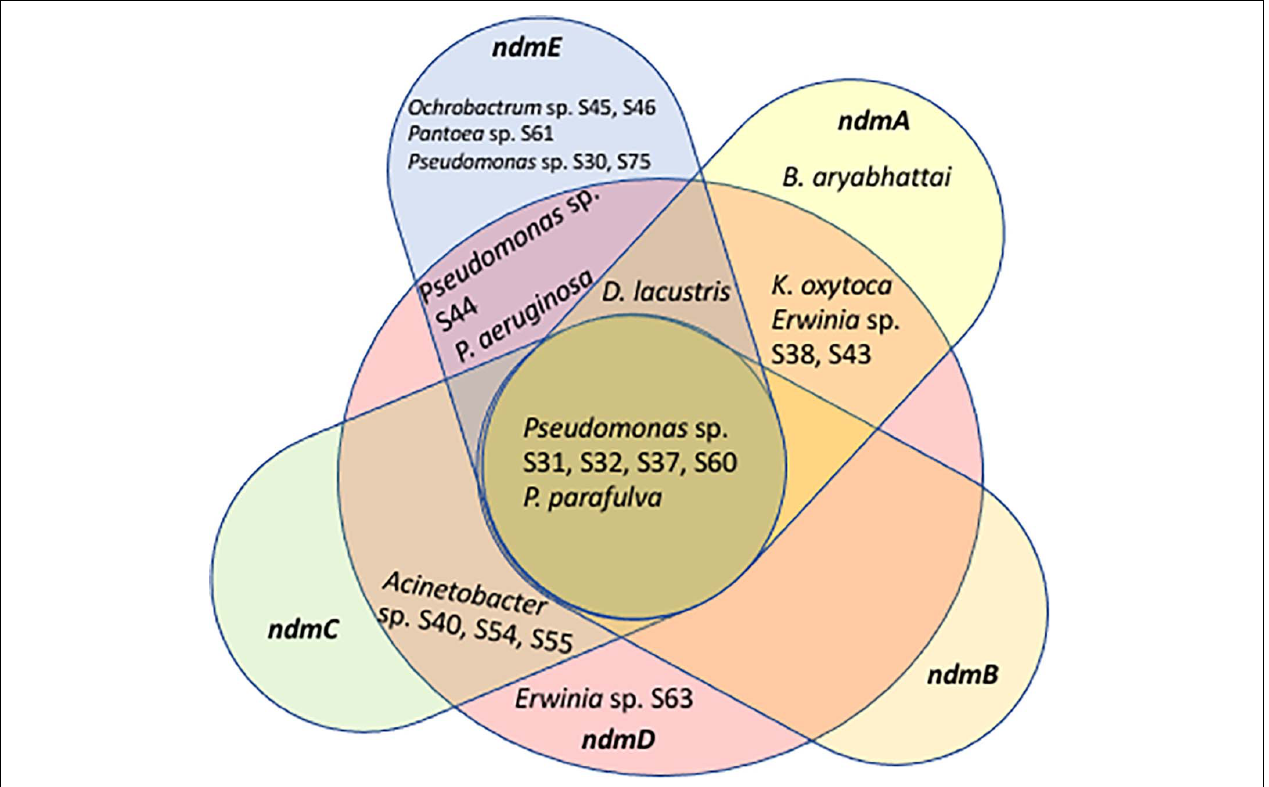
FIGURE 3 | Venn diagram showing genes involved in the caffeine N-demethylation pathway shared among Acinetobacter sp. S40, S54, S55, Bacillus aryabhattai , Delftia lacustris , Erwinia sp. S38, S43, S63, Klebsiella oxytoca , Ochrobactrum sp. S45, S46, Pantoea sp. S61, Pseudomonas sp. S30, S31, S32, S37, S44, S60, S75, P. aeruginosa , and P. parafulva